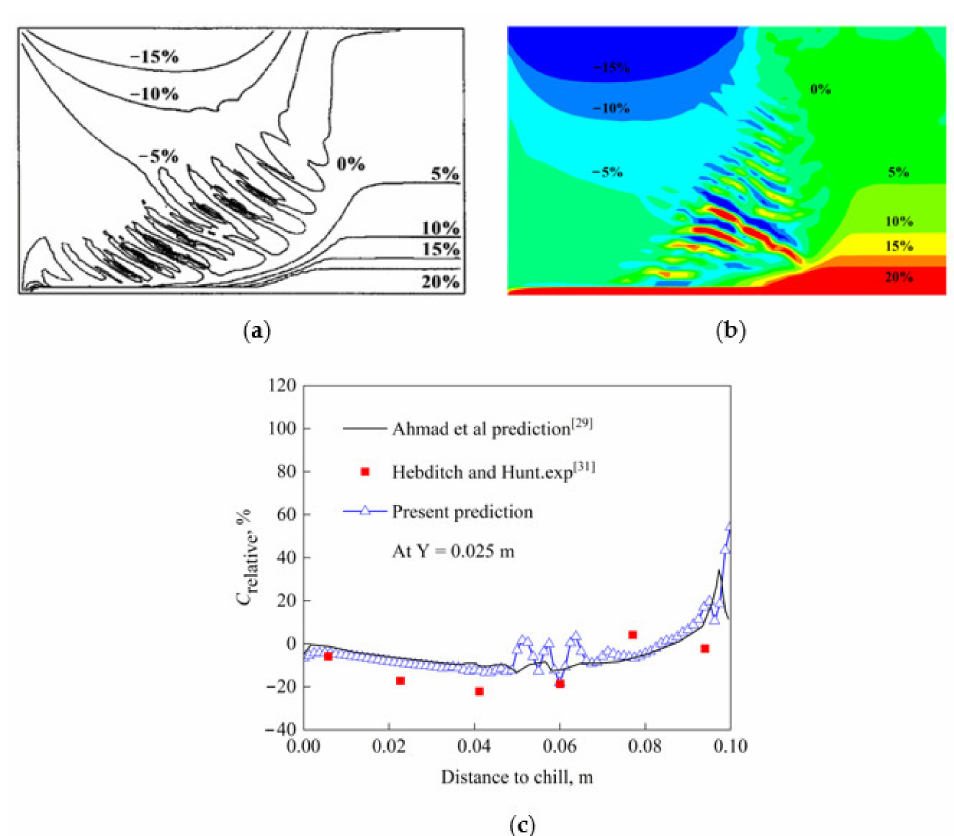
Figure 6. Comparison of C relative in the cavity: ( a ) at 400 s from the literature; ( b ) this paper; ( c ) at 0.025 m from the bottom of the cavity after